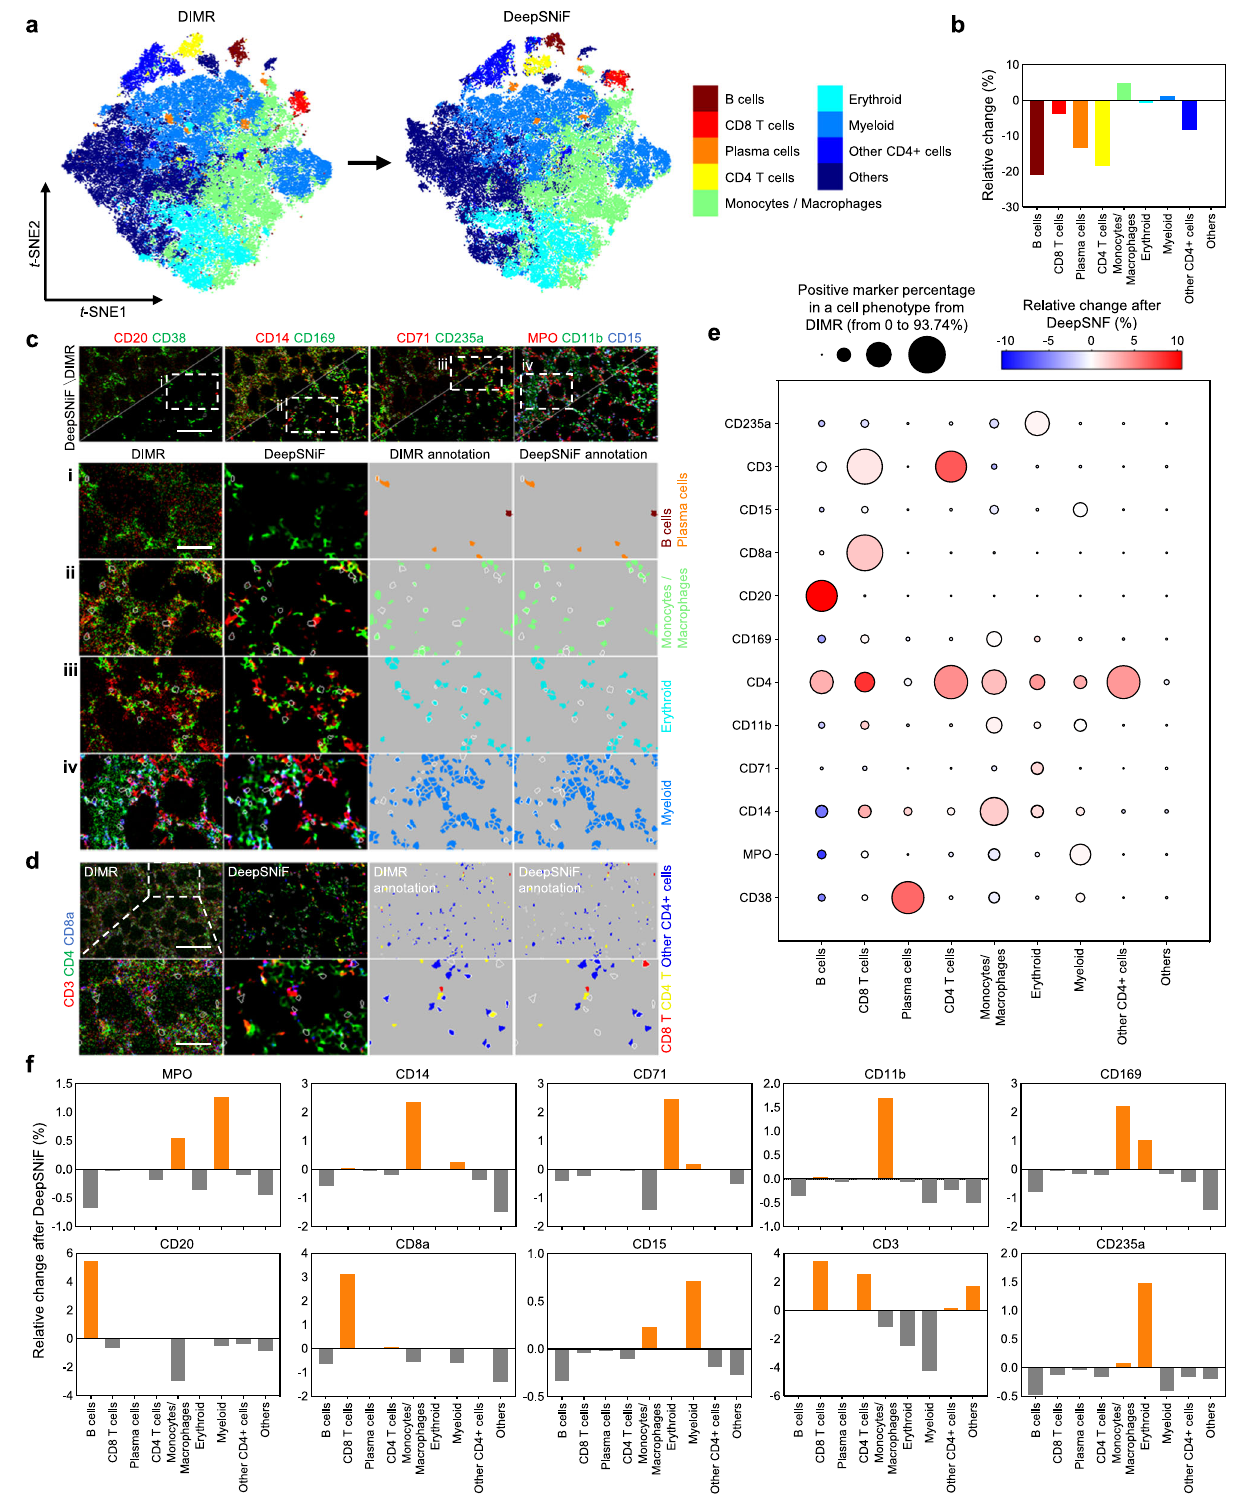
Fig. 3 | DeepSNiF enhances automated cell phenotyping on human bone mar- row IMC data. a t -SNE plots of DIMR and DeepSNiF with cell phenotyping results. b The relative change in cell phenotypes before and after DeepSNiF. c , d Comparisons of DIMR and DeepSNiF-processed IMC images labeled with dif- ferent cell markers, and the corresponding cell annotation results. The sub-panels (i) – (iv) in c and the bottom row in d correspond to the white dashed box region selection in their fi rst panels, respectively. The white contours represent the dif- ferential phenotyping results between DIMR and DeepSNiF. e DeepSNiF enhances the sensitivity of cell phenotyping. After DeepSNiF processing, the non-speci fi c